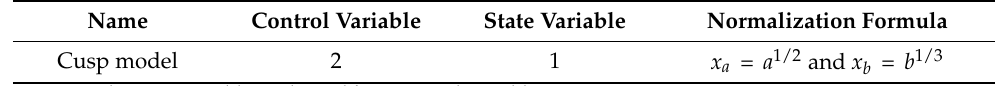
Table 1. Normalization formulas for catastrophe theory.